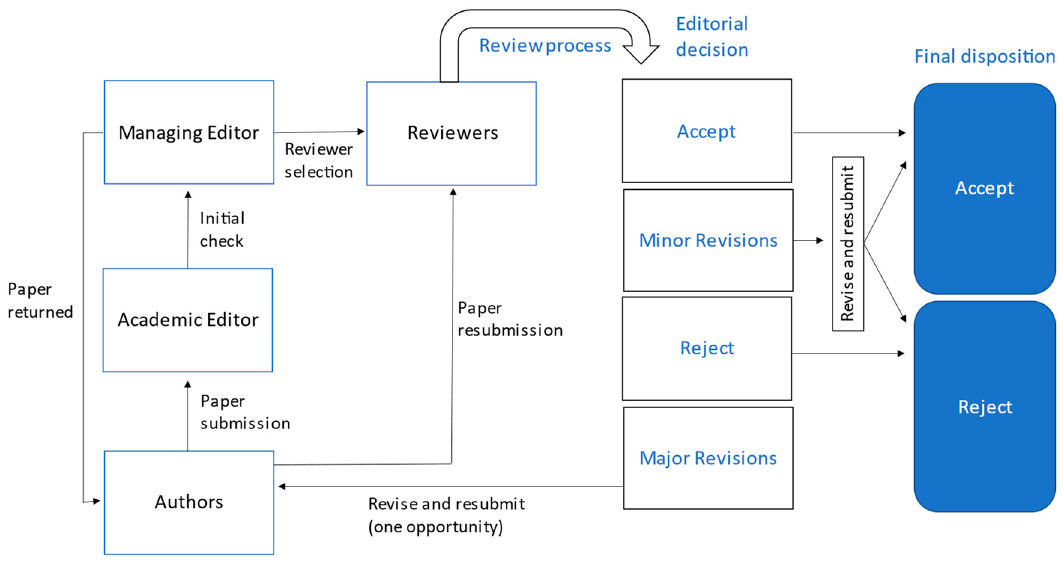
Figure 1. The review process for Tourism and Hospitality .